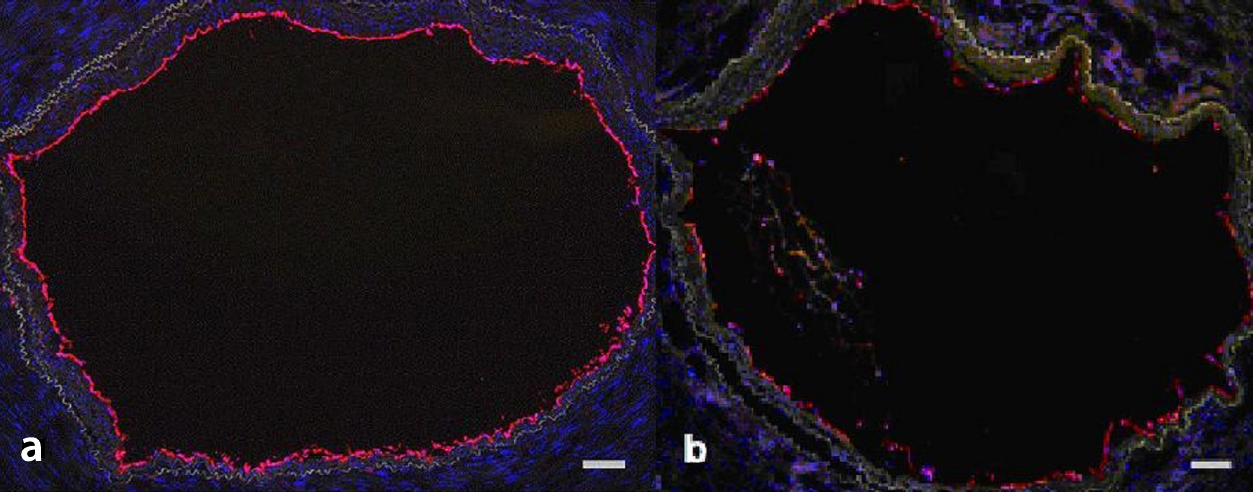
Fig. 3 – Representative micrographs showing endothelium (red) of radial artery after treatment with papaverine 0.5 mg/ml (a) and 2 mg/ml (b). Note progressive damage to the endothelial lining. Cell nuclei counterstained by DAPI (blue). Bar = 200 μm.